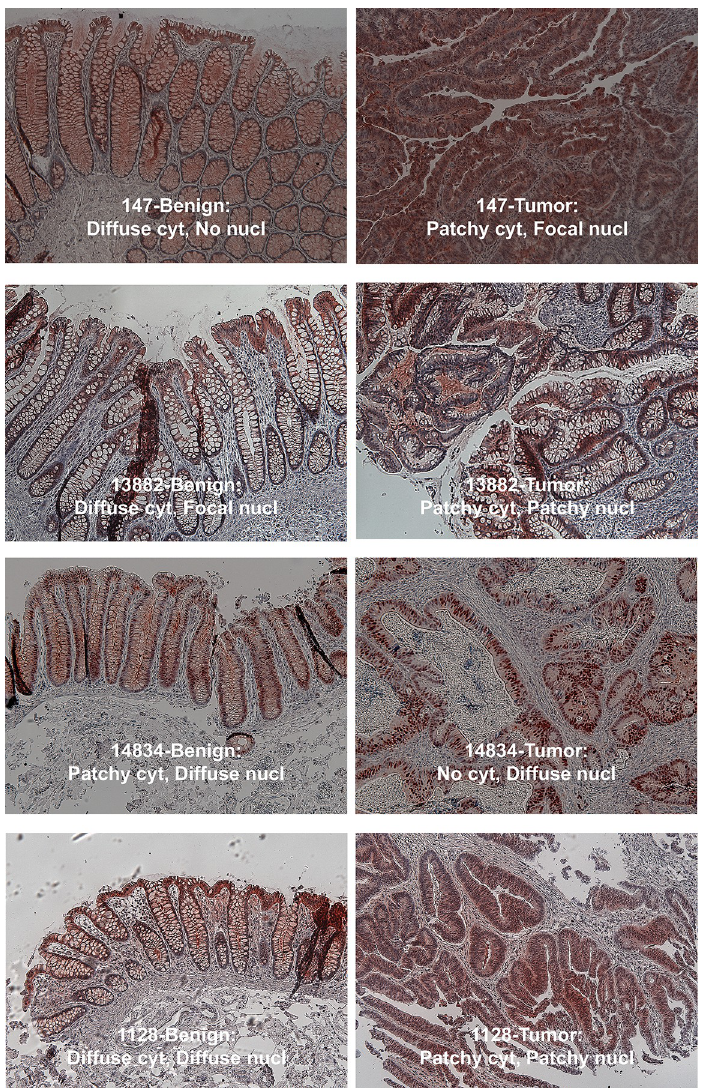
Fig 11. Acss2 is more frequently nuclear localized in human colon cancer. Immunohistochemical staining for Acss2 was performed on sections of paired human colon cancer and normal adjacent tissue samples mounted on the same slide. Low magnification (10x) select images were obtained for representative regions where possible. Scoring of the entire slide as well as select images was performed for intensity and pattern as detailed in methods. Examples of scoring determinations is shown for a subset of select